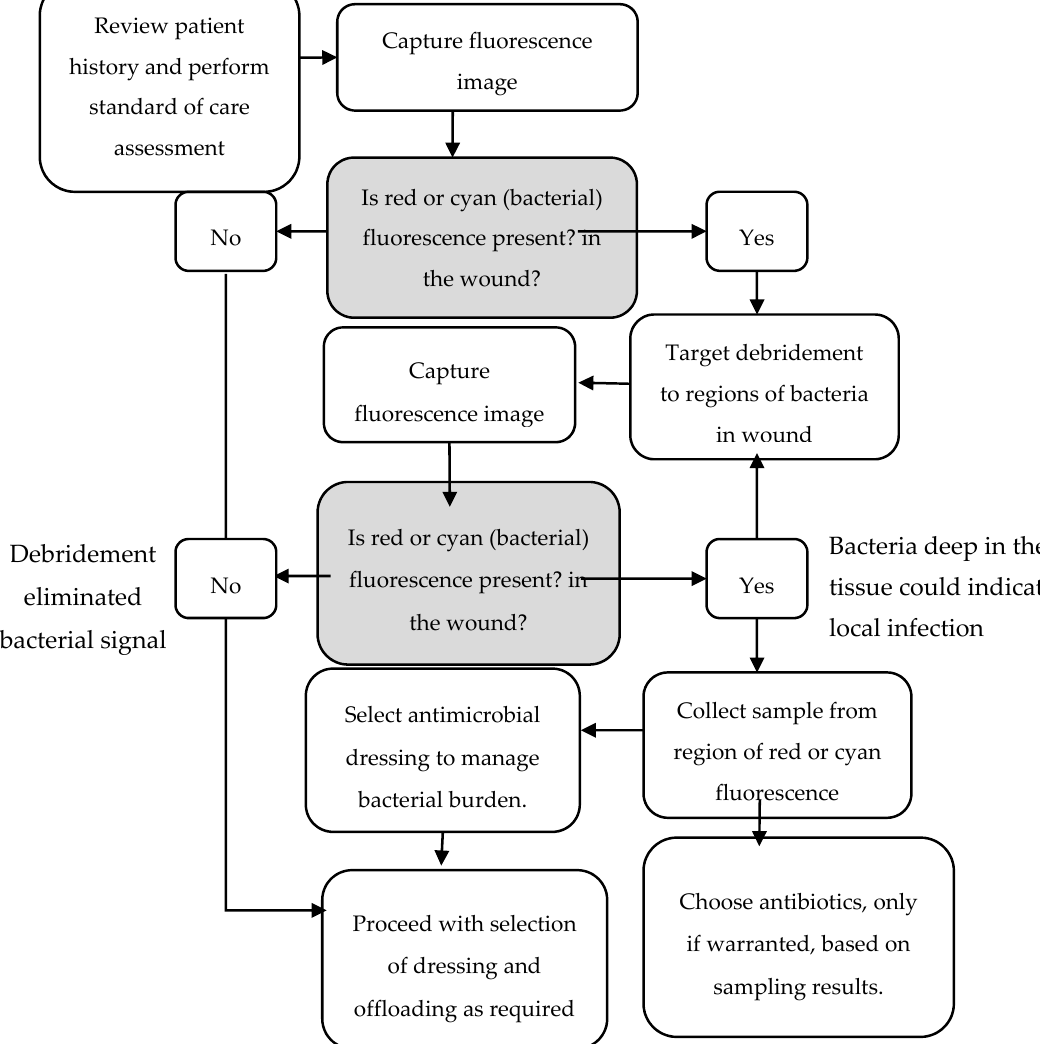
Figure 3. This decision tree describes how fluorescence imaging information impacted treatment selection. The presence of red or cyan fluorescence, indicative of moderate-to-heavy bacterial load, after debridement, prompted the clinician to perform additional debridement or wound sampling, as needed. Fluorescence information informed dressing selection. Antibiotics were prescribed only if indicated from sampling results except in cases where there were other clear signs or symptoms of infection present.